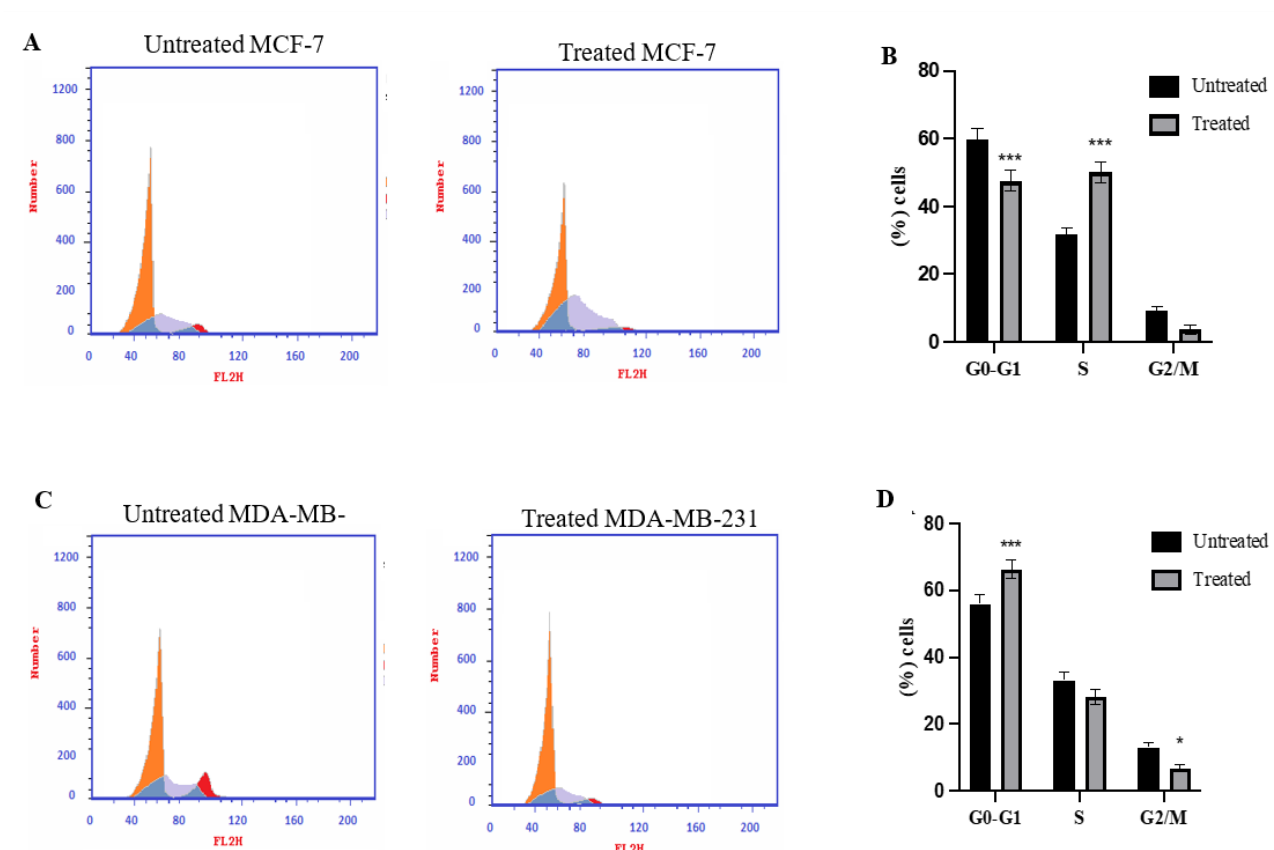
Figure 3. Effect of azilsartan on cell cycle phase distribution of MCF-7 and MDA-MB-231 breast cancer cell lines determined by flow cytometric analysis. ( A , C ) Representative histograms for MCF-7 and MDA-MB-231 breast cancer cell lines, respectively, after PI staining. ( B , D ) Percentage of cells in the various cell cycle phases in MCF-7 and MDA-MB-231 breast cancer cell lines, respectively. Data represent mean ± SD, n = 3. Significant difference was analyzed by Two-way ANOVA test, where * p < 0.05, *** p < 0.001 compared to untreated